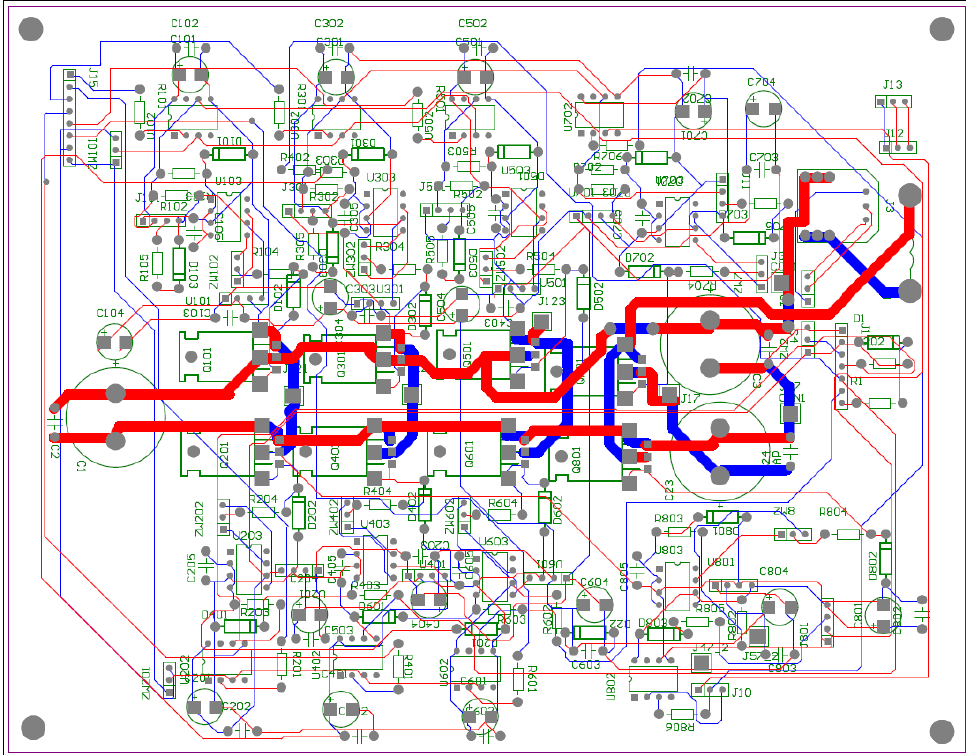
Figure 19. Electronic commutator circuit board design.